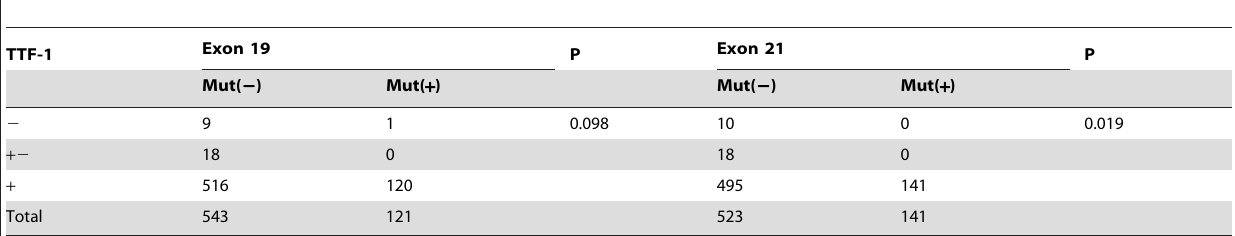
Table 4. The relationship between TTF-1 expression and EGFR exon 19 and exon 21 mutations.